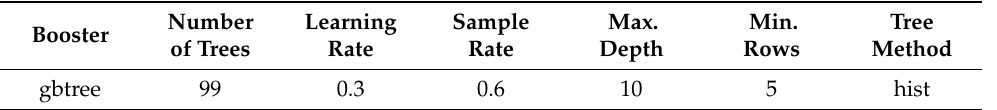
Table 6. XGBoost